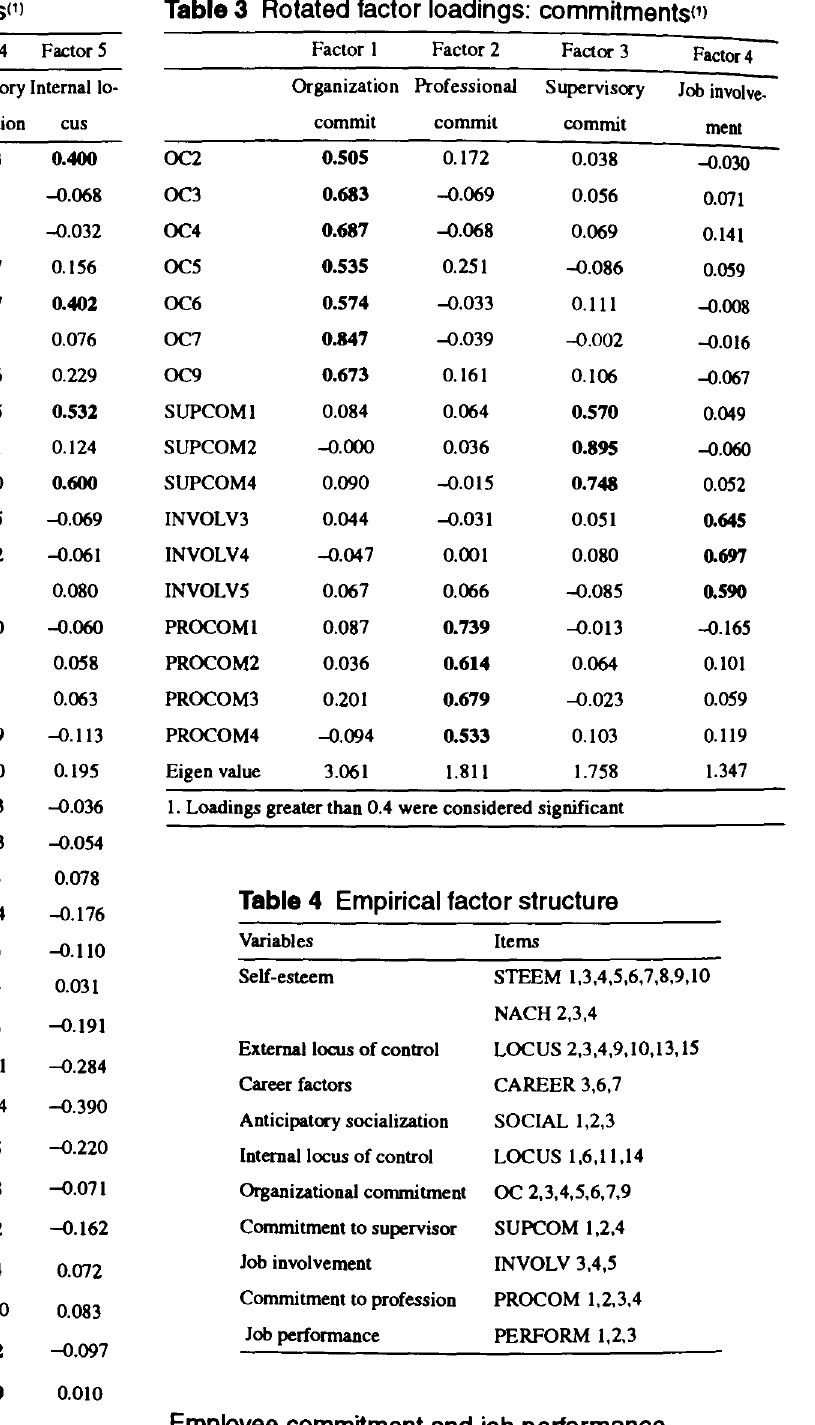
Table 2 Rotated factor loadings: antecedents<1 1 Table3 Rotated factor loadings: commitmentsc1,